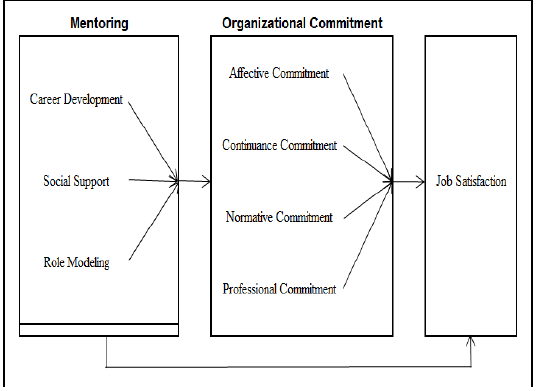
Figure I . Theoretical Research